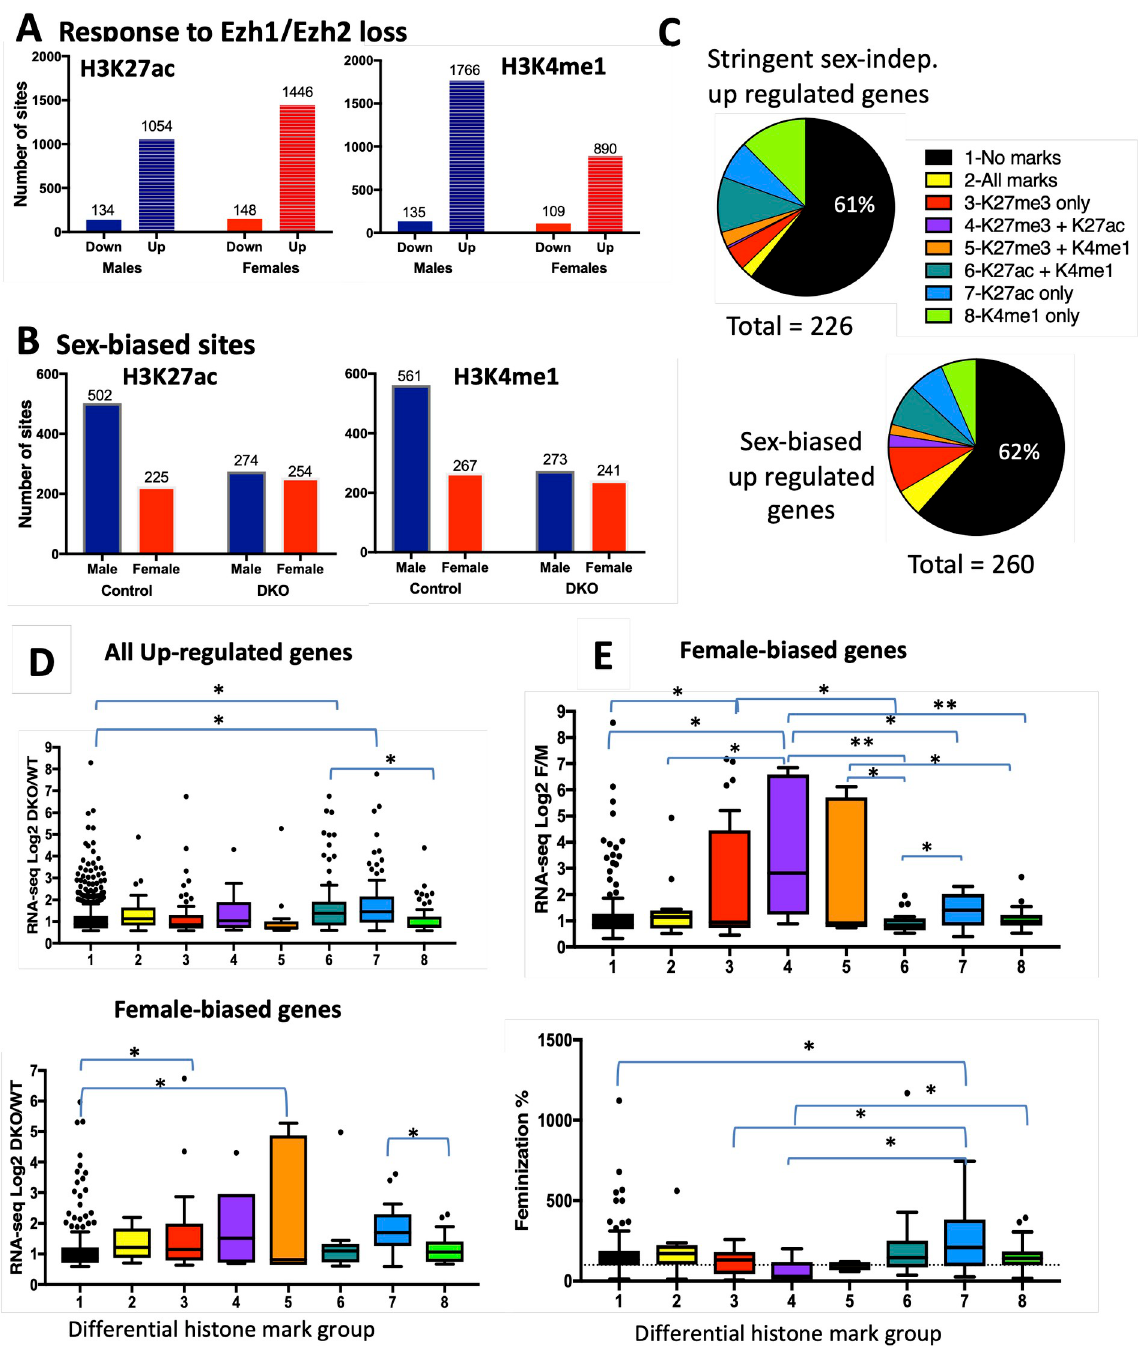
Fig 6. De-repression of gene expression and responsive histone marks. ( A ) Number of sites that show a significant decrease (Down) or a significant increase (Up) in each histone mark in E1/E2-KO male and E1/E2-KO female liver compared to sex-matched control liver. ( B ) Number of male-biased sites (Male) and number of female-biased sites (Female) for H3K27ac and H3K4me1 in control liver, and in E1/E2-KO liver. See listings in S6 Table. ( C ) Shown at the right are 8 different combinations of histone mark changes, one of which was assigned to each E1/E2-KO-responsive gene based on whether there was a decrease in H3K27me3 marks at either the gene body or promoter region, and/or an induction of H3K27ac marks or of H3K4me1 marks, as determined by GREAT analysis (see Methods). Shown is the histone mark pattern distribution for the 226 stringent-sex independent genes up-regulated in E1/E2-KO male liver ( upper pie chart) , or for the 260 sex-biased genes up-regulated in E1/E2-KO male liver ( lower pie chart ). These gene sets are based on data shown in Fig 2 and S3 Table for 846 genes up- regulated in male liver, of which 260 are sex-biased (154+86+16+4 = 260) and 226 are sex-independent (143 + 83 = 226). ( D ) Upper box plots show the distribution of log2 fold-change expression values for E1/E2-KO-male vs. wild-type male liver for the 846 genes up-regulated in male